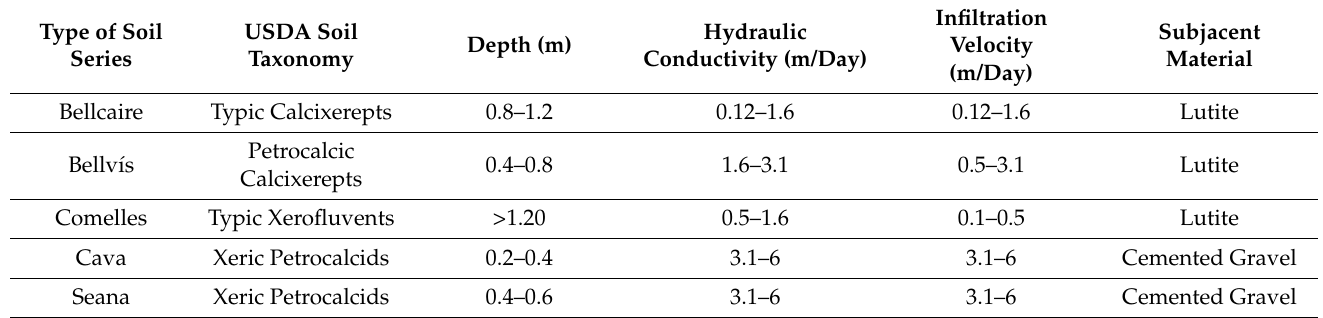
Table 1. Type of soil [38], USDA Soil Taxonomy [39], depth of the soil, hydraulic conductivity [40], infiltration velocity [40] and subjacent material of main soils in the studied area according to the “Detailed Soil Survey Map of Catalonia of the Irrigated Area by Algerri-Balaguer Canal”